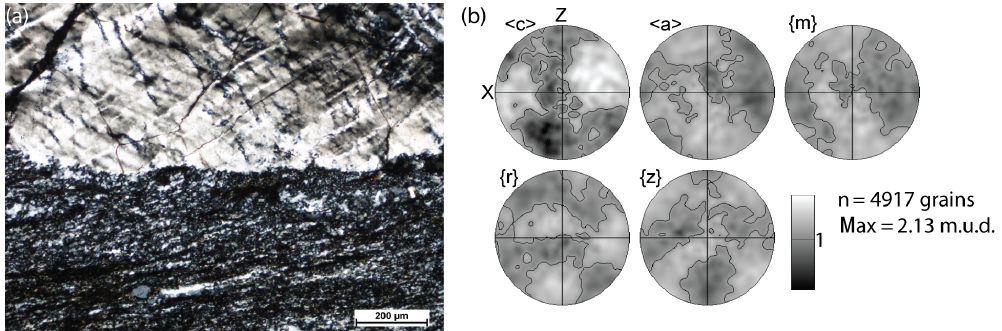
Figure 10. EBSD analysis of quartz in the ultramylonite. (a) Microstructure of the recrystallized quartz from domain 3 in the ultramylonite. (b) Pole figure of recrystallized quartz grains from (a) . Only grains from recrystallized aggregates in the ultramylonite were